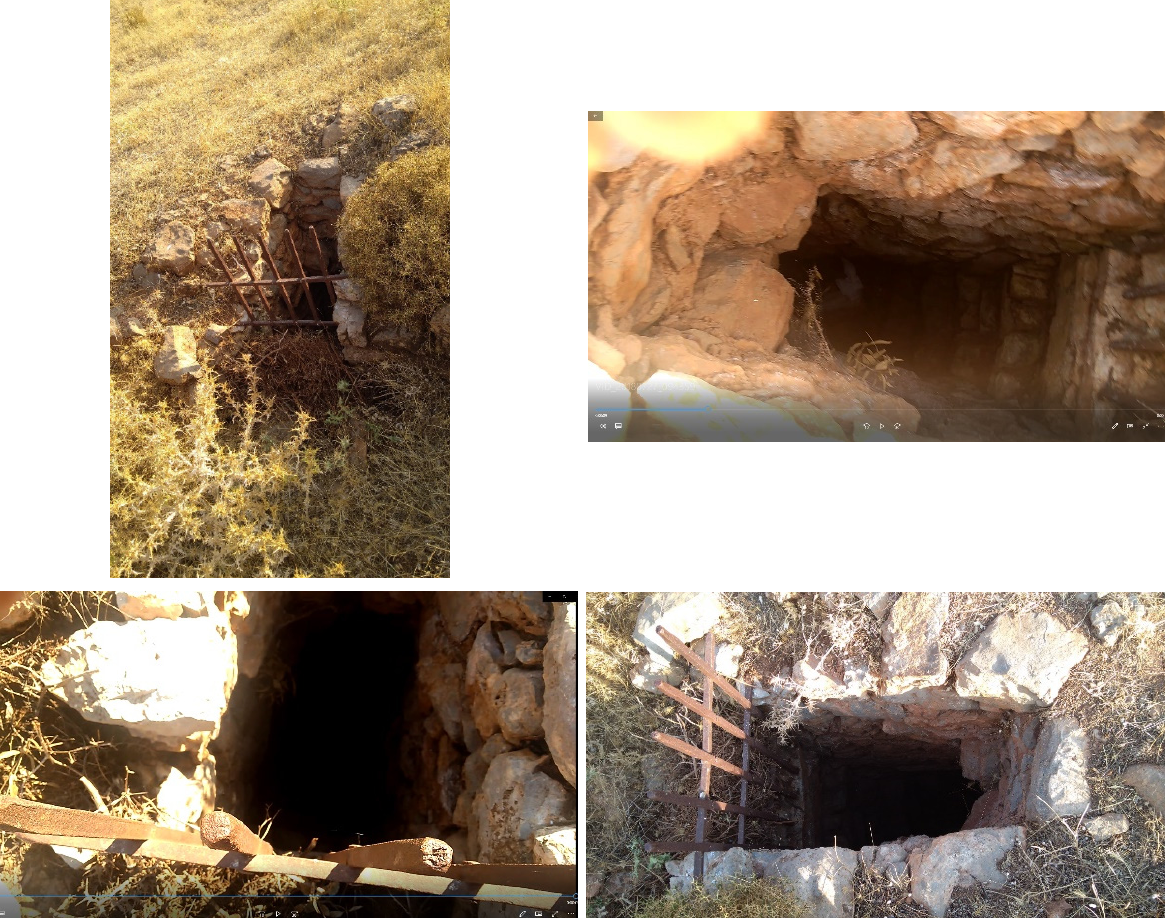
Figure 13. The southern sinkhole in the center of Meteles plain valley. From the present surface, the top of the interior with steps. Photos are taken from various angles of same sinkhole 2 (© IL). The second one, north of the plain at the bottom of the foot slope of Kastrouli hill (Figure 14) and built with medium-sized stones, includes a cistern of about 5 by 3 m with a drainage sink, and the drainage location is covered by sediments. This sink was of par- ticular importance, as it has a small-sized arched bridge made with stone block and un- polished stones with mortar, and it is of a larger construction and an obviously engineered channel to drain the water.